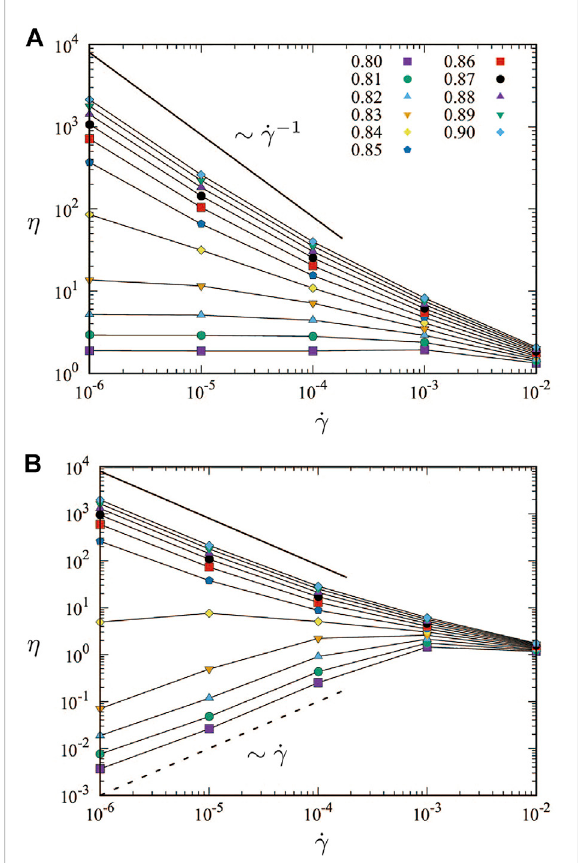
FIGURE 1 Double logarithmic plots of the shear viscosity η and shear rate _ γ , where the models (A) A and (B) B are used for the damping force, f d ij . The packing fraction of the particles ϕ increases as listed in the legend of (A) . The solid lines indicate shear thinning, η ~ _ γ − 1 , whereas the dashed line in (B) represents the Bagnold scaling (shear thickening), η ~ _ γ